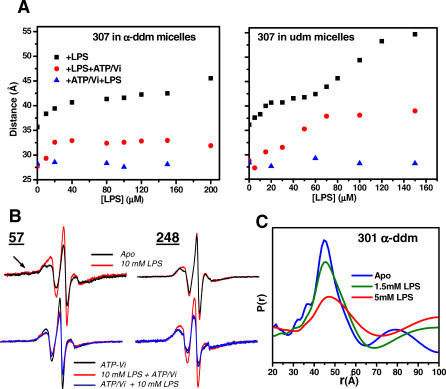
LPS-Induced Structural Changes in MsbA(A) Biphasic increase in distance between chamber-facing residues. The onset of the monotonic phase depends on the solubilizing detergent. Udm: undecyl-maltoside. (B) High concentration of LPS induces the appearance of a mobile component in the ESR spectral lineshape. (C) A population of transporters with an increased separation between monomers as reflected in the P(r) at site 301. This effect is inhibited by prior formation of the ADP/Vi intermediate. Subsequent ATP hydrolysis only partially restores the original lineshape. ESR samples were in 0.08% α-ddm.